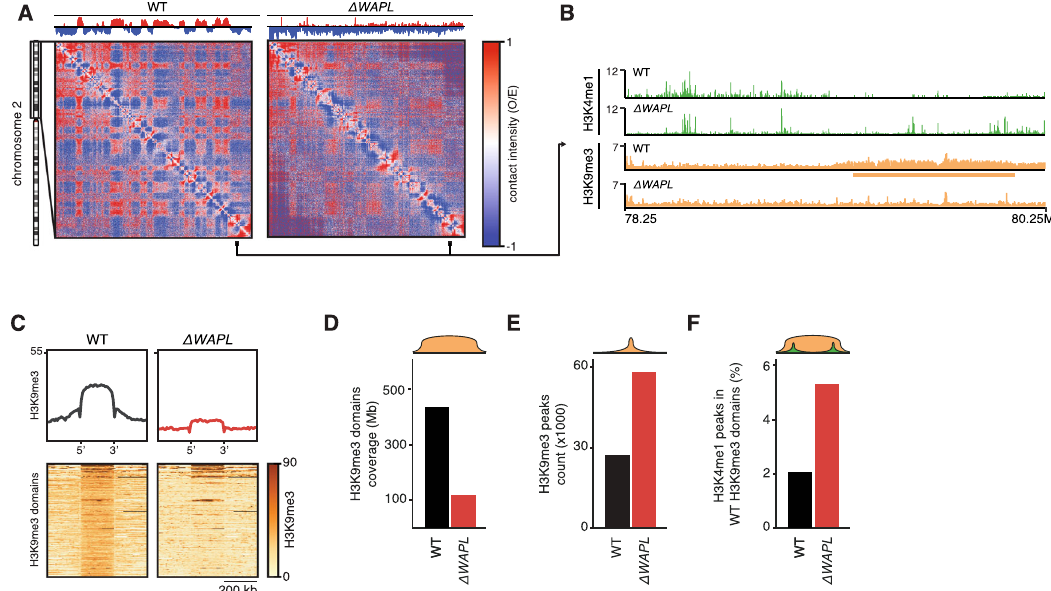
Fig. 1 Stabilization of cohesin results in the loss of H3K9Me3 domains. A Observed over expected (O/E) Hi-C matrixplots at 100 kb resolution show the contact frequencies for wild-type (WT) and Δ WAPL cells for the p-arm of chromosome 2. Contact matrices are visualized using GENOVA. Segregation of the genome into A and B compartments is quanti fi ed using the compartment score 11 , shown above the matrix. B ChIPseq tracks for H3K4me1 and H3K9me3 in WT and Δ WAPL cells. Orange rectangle indicates the position of a H3K9me3 domain. C Alignment of H3K9me3 signal on H3K9me3 domains identi fi ed in WT H3K9me3 ChIPseq data. Average signal is shown on top, bottom shows heatmap of the raw signal. D Quanti fi cation of the genomic coverage of the H3K9me3 domains in WT and Δ WAPL cells. E Quanti fi cation of the total number of H3K9me3 peaks in WT and Δ WAPL cells. F Percentage of H3K4me1 peaks found in genomic regions that are identi fi ed as H3K9me3 peaks in WT